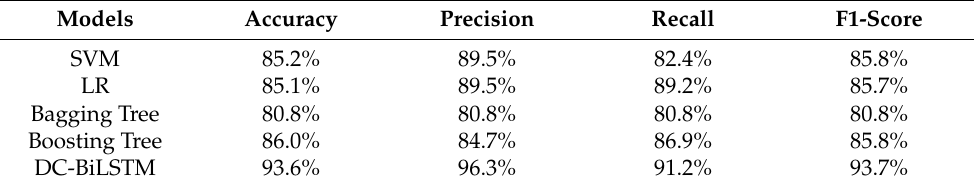
Table 5. Comparative analysis of the performance of multiple classifiers in distinguishing between low-grade and high-grade disease. The performance metrics are for the internal test dataset.